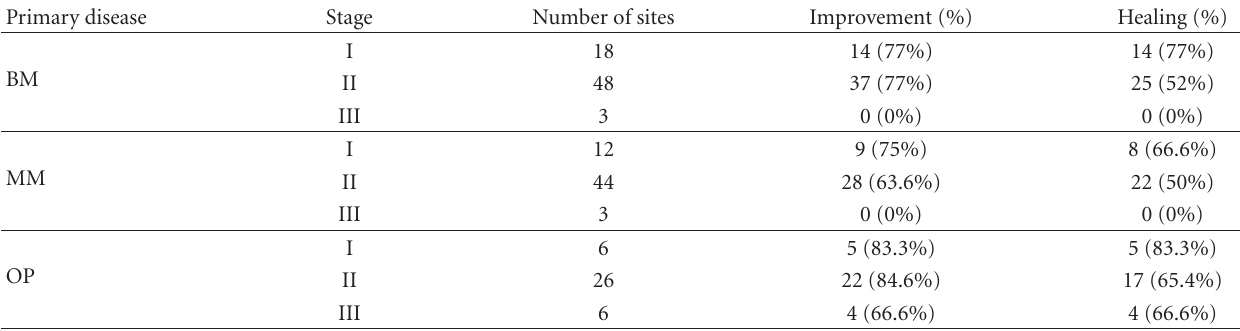
Table 6: Improvement and healing in relation with primary disease and BRONJ stage independently by the therapy (BM: bone metastasis,